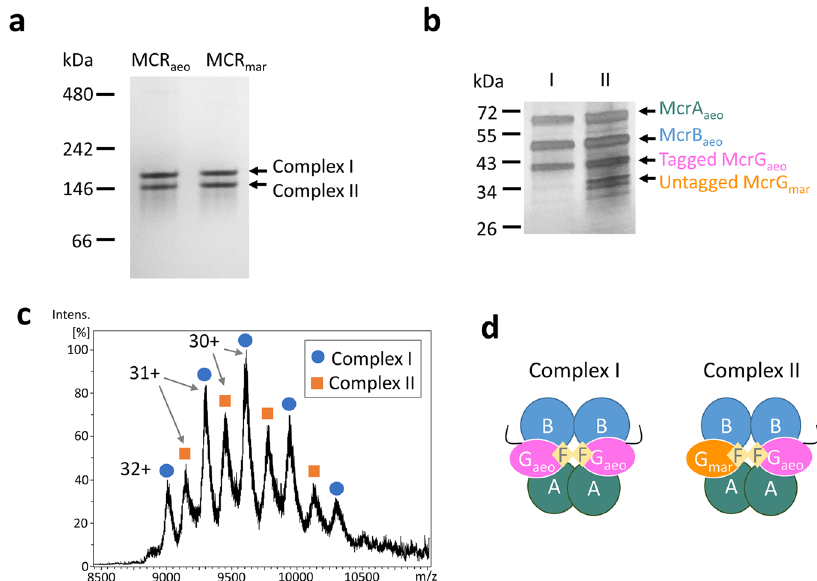
Fig. 3 Characterization of recombinant complexes. a Native-PAGE analysis of the puri fi ed recombinant MCR aeo and MCR mar . Both constructs had a Flag- Strep 2 tag added to the N-terminus of McrG. b The two complexes of MCR aeo were eluted from native-PAGE gel slices, analyzed by SDS-PAGE, and silver stained. c The native molecular masses of the MCR aeo complexes I and II were determined as 288.4 and 283.8 kDa, respectively, by intact protein mass spectrometry. The charges of the peaks are labeled. d Models of complexes I and II. A, B, and G aeo represent M. aeolicus McrA, McrB, and McrG subunits, respectively. G mar denotes the untagged host M. maripaludis McrG. The black line symbolizes the tag. F stands for coenzyme F 430 .